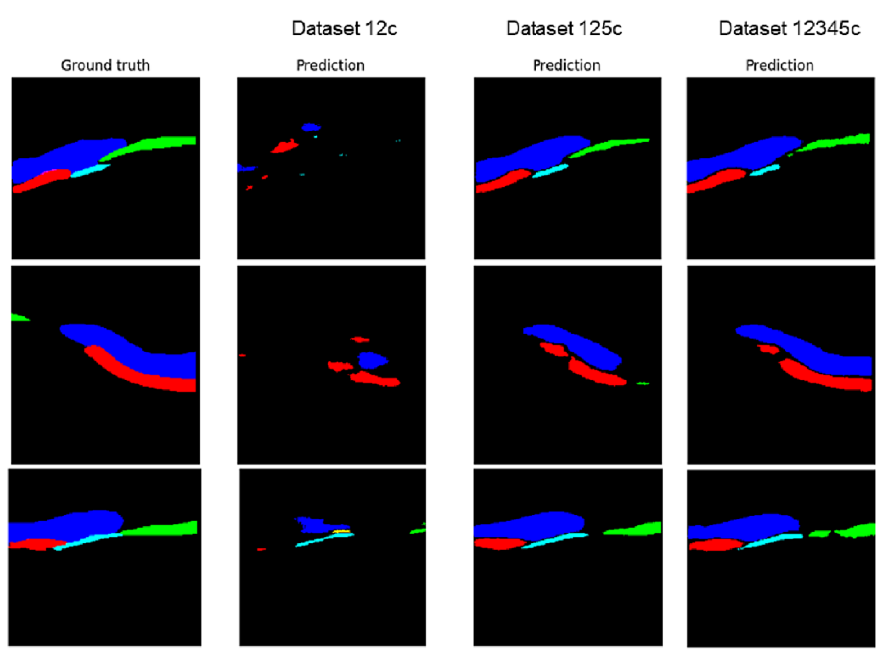
( below ) for an uncorrected dataset ( left ) vs. a corrected dataset ( right ).